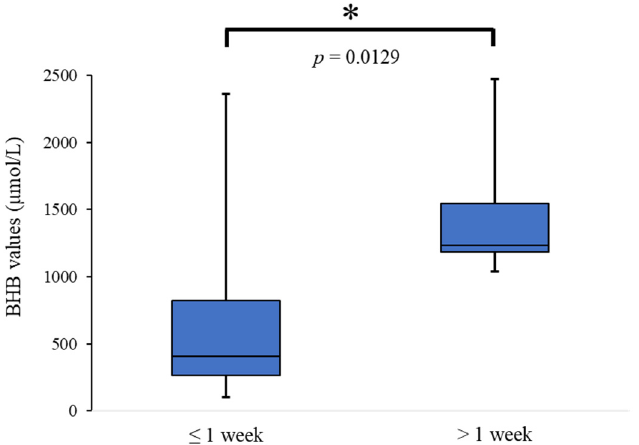
Figure 2. Comparison of BHB values between the PMI of ≤ 1-week and >1-week groups. The median values are significantly higher in the PMI of the >1-week group than in the PMI of the ≤ 1-week group. * means statistical significance ( p < 0.05). BHB; β -hydroxybutyrate.